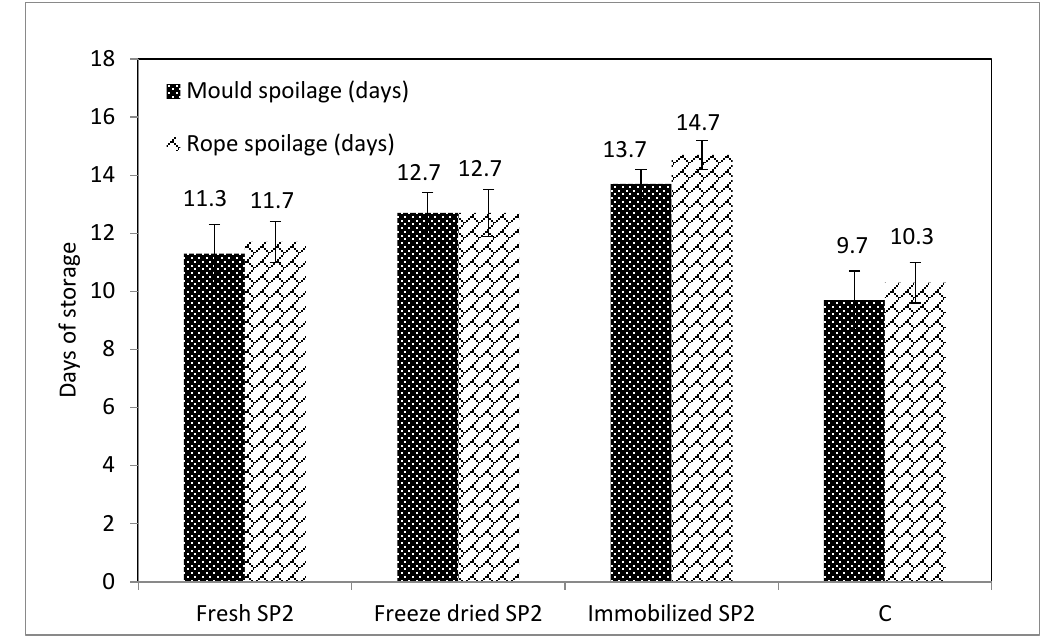
Figure 2. Resistance against rope and mold spoilage of breads made with sourdoughs containing P. pentosaceus SP2 cells (Fresh SP2), freeze-dried P. pentosaceus SP2 cells (Freeze-dried SP2), immobilized freeze-dried P. pentosaceus SP2 cells (Immobilized SP2), as well as with the commercial sourdough (C).